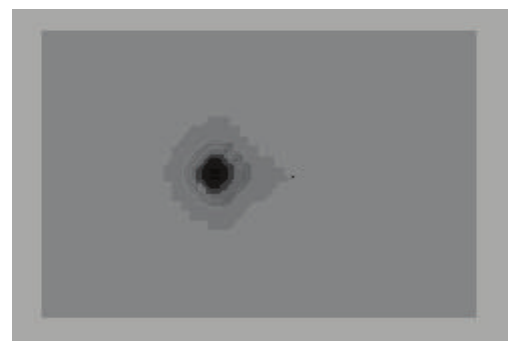
Figure 7: DOC distribution at 180 days with 200 t/day for both recharge and production.